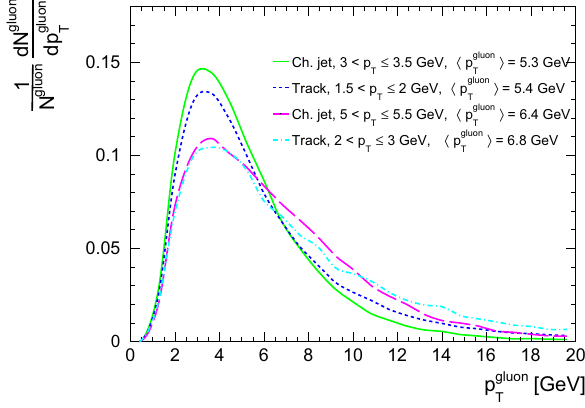
Fig. 3 Gluon p T distributionforvariousfinal-statetriggersasobtained using Pythia 8 CUETP8M1